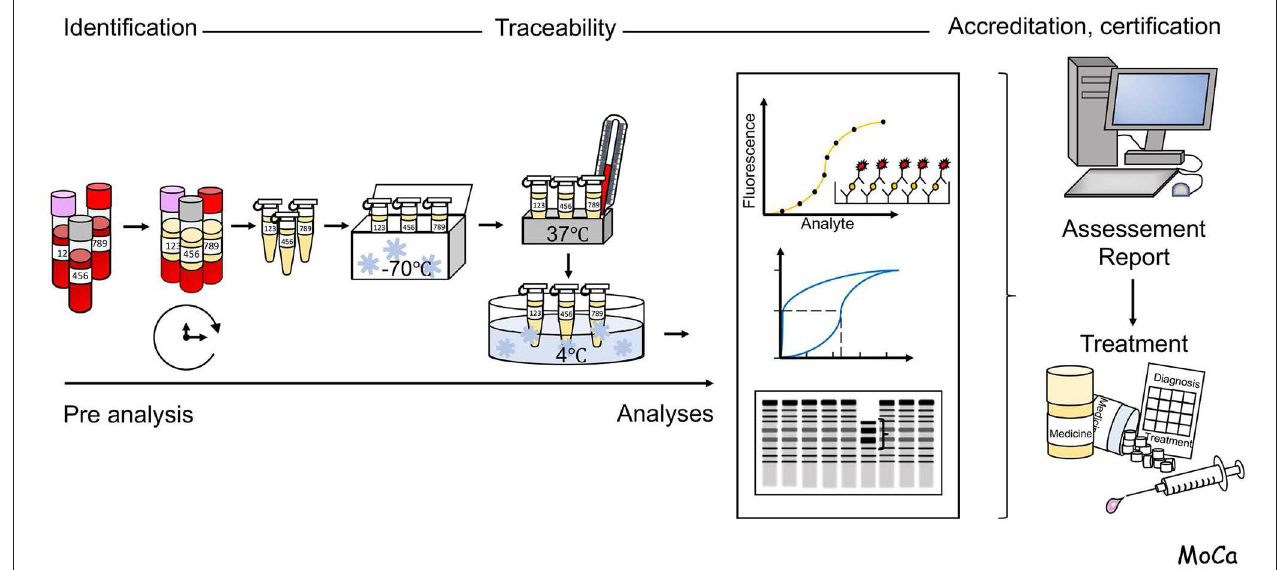
FIGURE 2 | Schematic overview of the flow of events in the process for analysis of clinical patient samples. Reliable analysis of samples requires the control of pre-analytical handling of and choice and validation of appropriate analytical techniques, Detailed information is given in the section “Pre-analytical handling and methodological